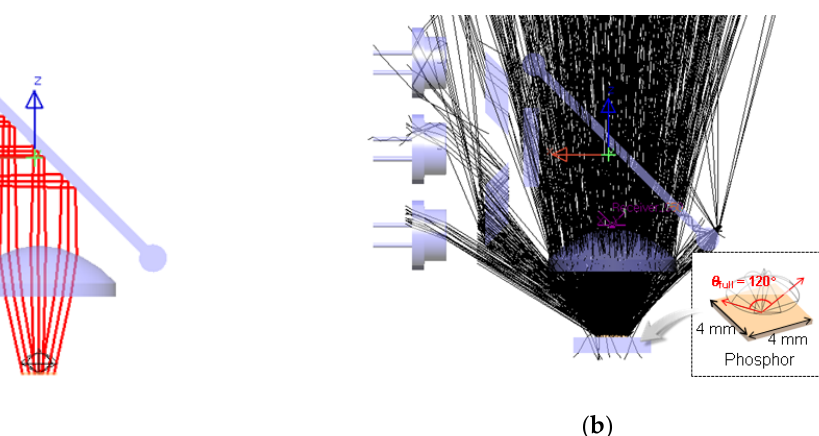
Figure 7. Phosphor and dichroic filter incident beam characteristics using a planar convex lens: ( a ) incident path from the laser diode to the phosphor; ( b ) incident ray characteristics to the dichroic filter.